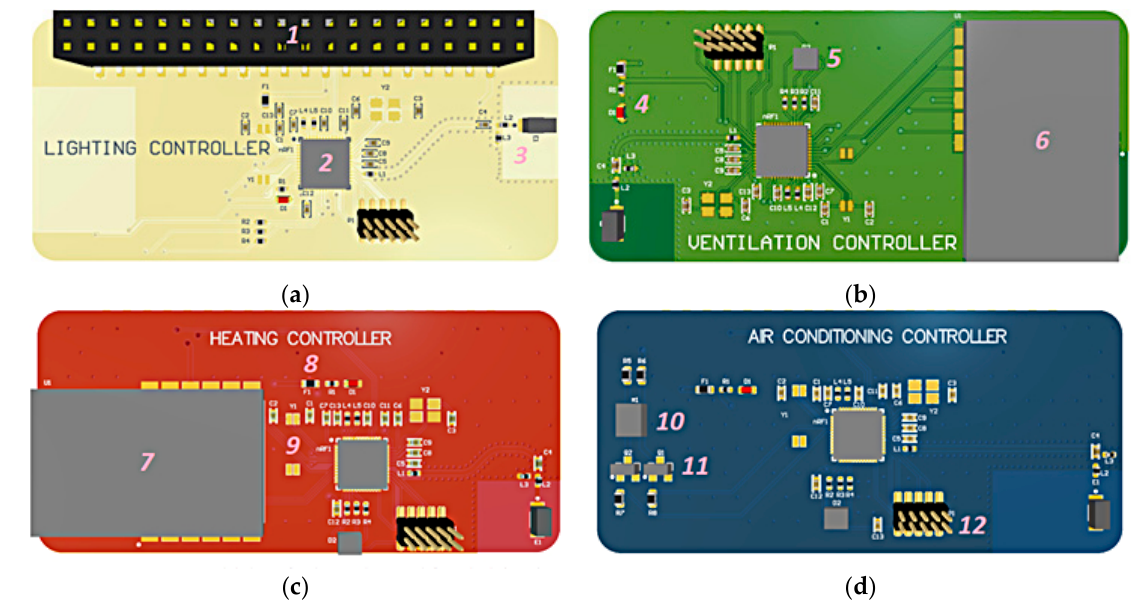
Figure 10. Three-dimensional visualization of a radio prototype comfort controller designed by CBRTI Sp. z o.o. Research and Development Center: ( a ) lighting controller where 1 stands for 40-pin strip for SBC, 2 stands for nRF52832 SoC, and 3 stands for ceramic antenna’s circuit; ( b ) ventilation controller where 4 stands for power indicators, 5 stands for application indicators (RGB), and 6 stands for ZigBee RF module; ( c ) heating controller where 7 stands for IEEE 802.15.4 RF module, 8 stands for simple OCP, and 9 stands for real-time clock (RTC); ( d ) air conditioning controller where 10 stands for IrDA ports, 11 stands for LED’s control circuits, and 12 stands for programmer connector.